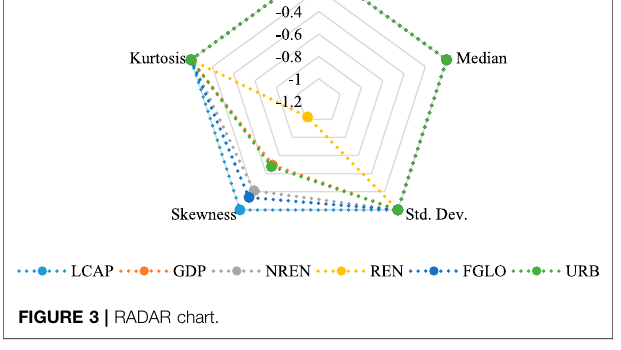
FIGURE 3 | RADAR chart.